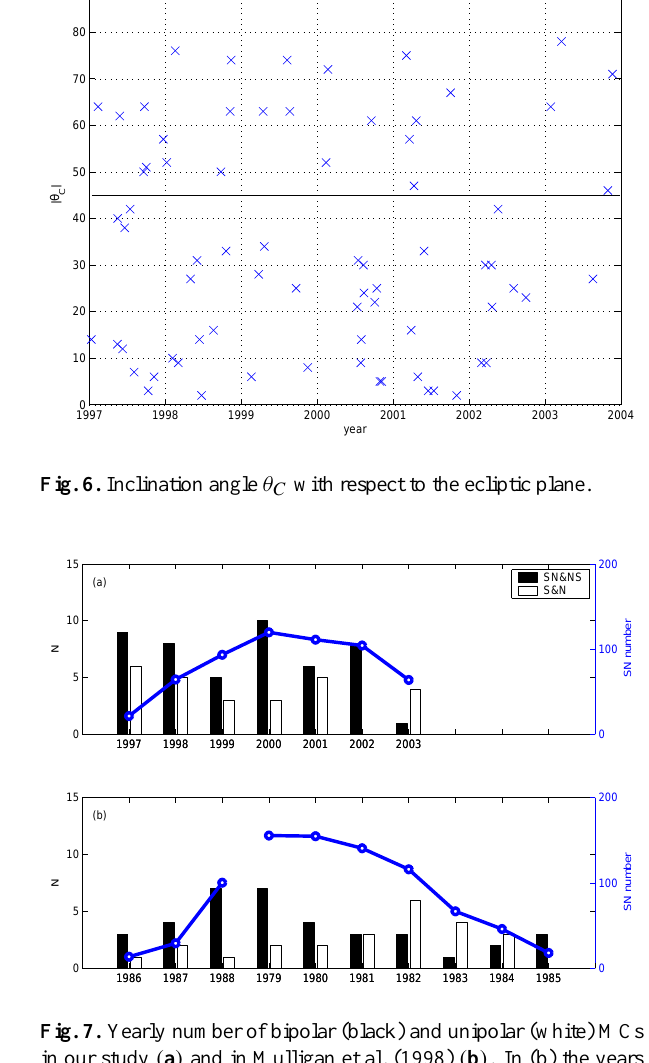
pansion speed. The black dashed line indicates the calcu- lated travel time from Eq. (2). A least-square fit curve of the same functional form as Eq. (2) but with newly derived co- efficients using travel times of 25 MC shocks in our study, T tr = 236 . 7 − 25 . 94ln (V exp ) is indicated by the blue line. The red line shows the same for CME-MC leading edge pairs, T tr = 233 . 9 − 23 . 55ln (V exp ). The standard deviation is 11.4